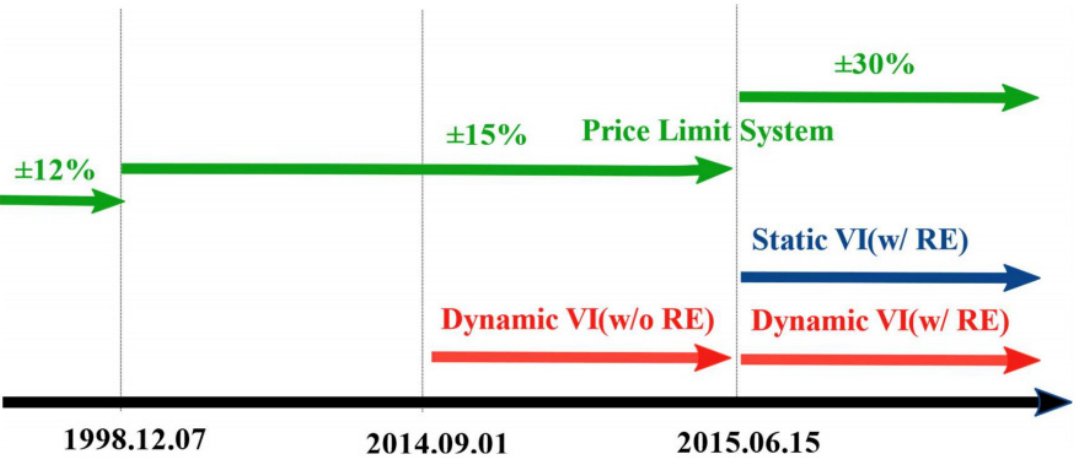
Figure 1. Time line in the KRX. The KRX has used a price-limit system to limit price movements for the day to a specified percentage (e.g., ±15% from 7 December 1998 to 14 June 2015). On 1 September 2014, the KRX adopted dynamic VI (without RE mechanism), while leaving the price limit unchanged. Then, on 15 June 2015, the exchange added static VI, expanded the price limit to ±30%, and simultaneously added RE mechanism to both dynamic and static VIs.